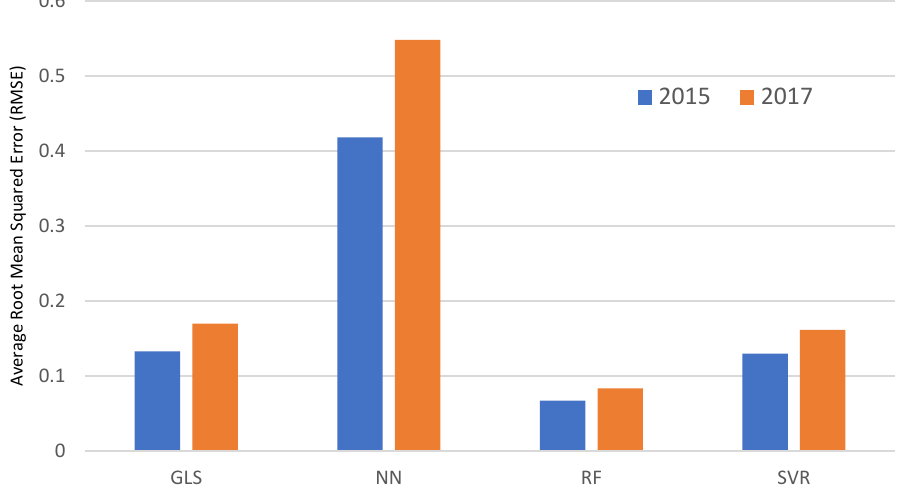
Figure 11. Comparison of average root mean squared error (RMSE) obtained from four machine- learning algorithms (on predicting poverty headcount rates of 2015 and 2017). Source: Calculation and graphics generated by authors.